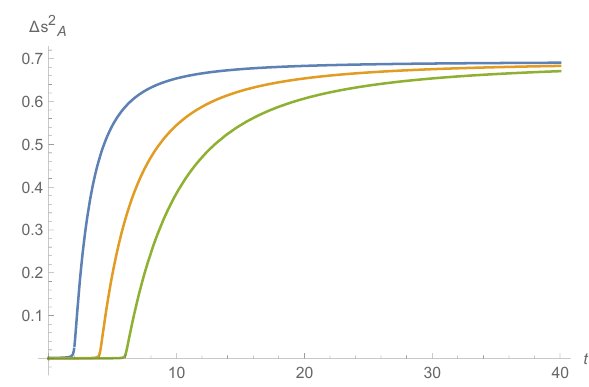
Figure 3. Real-time evolution of ∆ S (2) We keep (cid:15) = 0 . 1 in all